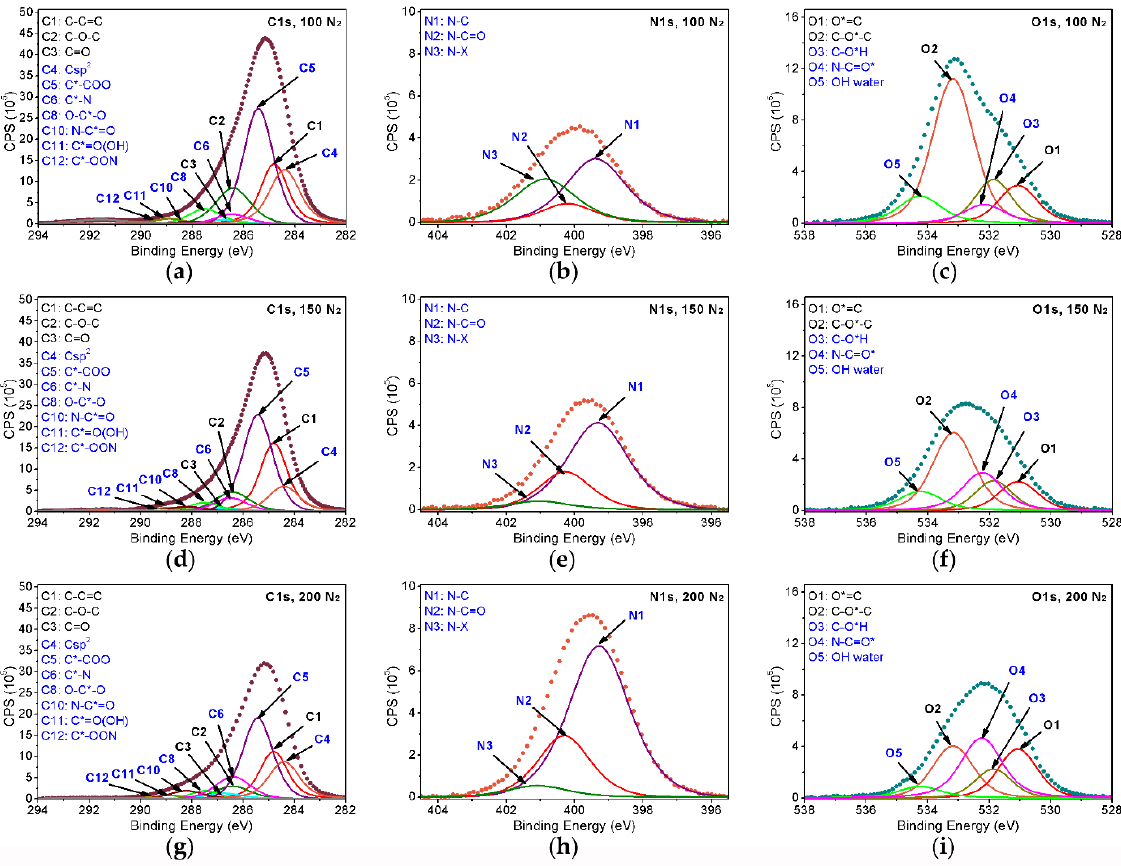
Figure 5. XPS spectra of PEEK modified with EUV radiation and nitrogen plasma: ( a ) C1s band—100 EUV pulses, ( b ) O1s band—100 EUV pulses, ( c ) N1s band—100 EUV pulses, ( d ) C1s band—150 EUV pulses, ( e ) O1s band—150 EUV pulses, ( f ) N1s band—150 EUV pulses, ( g ) C1s band—200 EUV pulses, ( h ) O1s band—200 EUV pulses, and ( i ) N1s band—200 EUV pulses.